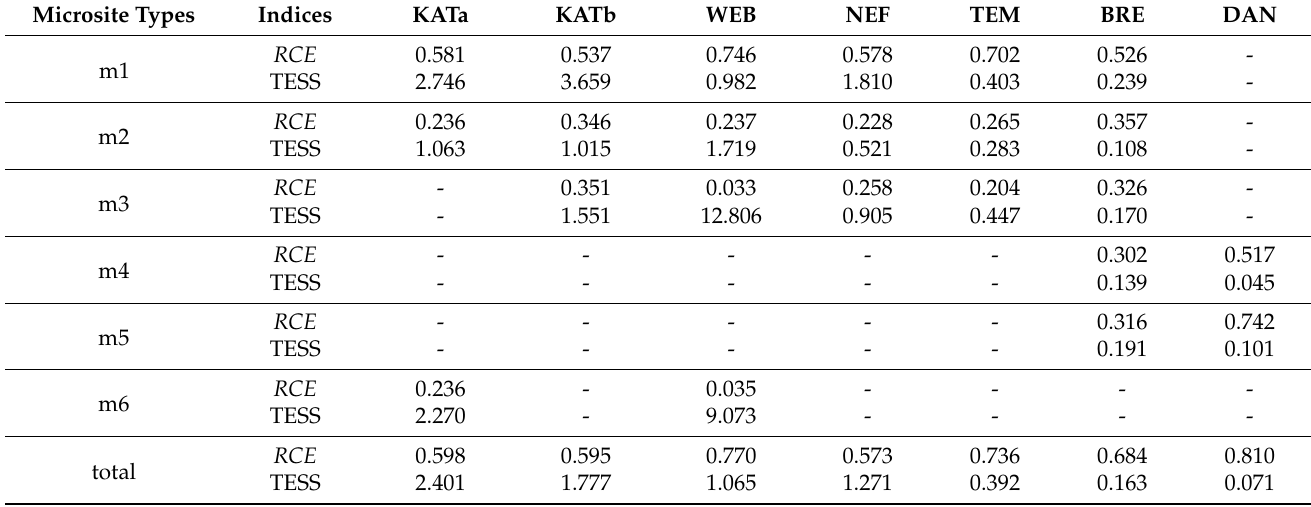
Table 5. Calculated aggregation indices ( RCE ) and mean growth spaces (TESS) per pine seedling (all ages included) separated by microsite type (m—microsite, m1—stand conditions without soil scarification, m2—skid trail, m3—skid trail border, m4—hollows or furrows, m5—mounds, m6—stand edge) for each study site. All RCE values are highly